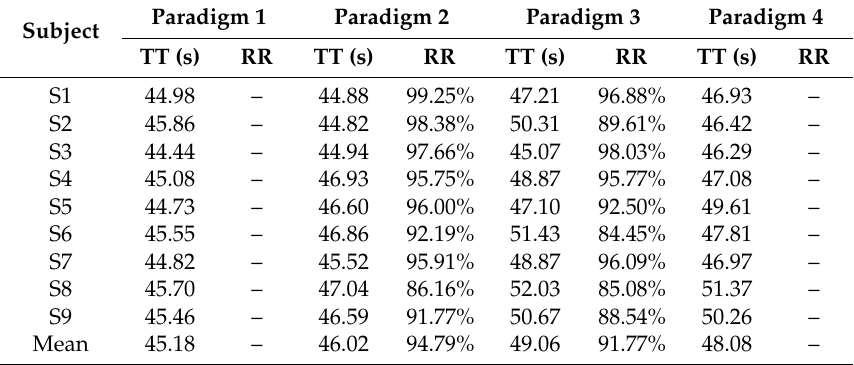
Table 9. The recognition rate and travel time for different online